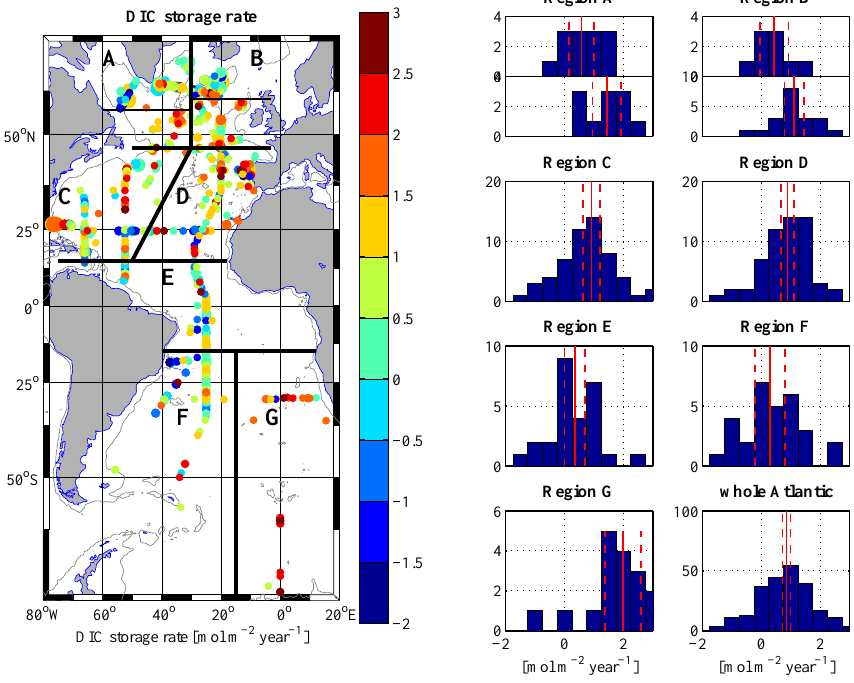
Fig. 2. Change in column inventory between two repeats of the same position, i.e. the storage rate (molm − 2 yr − 1 ) for DIC in the Atlantic Ocean. Left side panel: the average of storage rates for each location is shown with the color-coded marker; the sizes of the markers are made proportionally larger depending on the number of repeats at each position. The 2000m isobath is marked with a gray thin line. Right hand panels: histograms of the distribution of storage rates in 2 ◦ × 2 ◦ bins (see text) for the 7 regions and for the sum of all the regions; note that for regions A and B, we show the southern (lower panel) and northern (upper panel) sub-regions separately (thin black lines on the map). The average value and the 95% confidence intervals are marked with red vertical